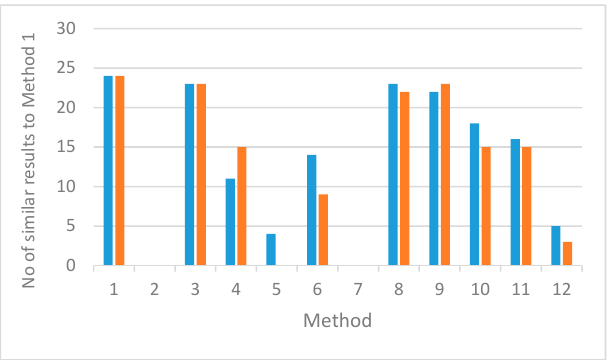
Figure 4. Phase 2: Column chart indicating similarity in molecular weight results for 24 heparin samples, between the USP Heparin Sodium monograph method (Method 1) and 11 other distinct chromatographic methods (Table S5). Blue columns plot M w data and orange columns plot M 24,000 . Data are taken from Table S3A,B; similarity criteria are for M w , values differ from Method 1 by less than 500 Da; for M 24,000 values differ from Method 1 by less than 10%.